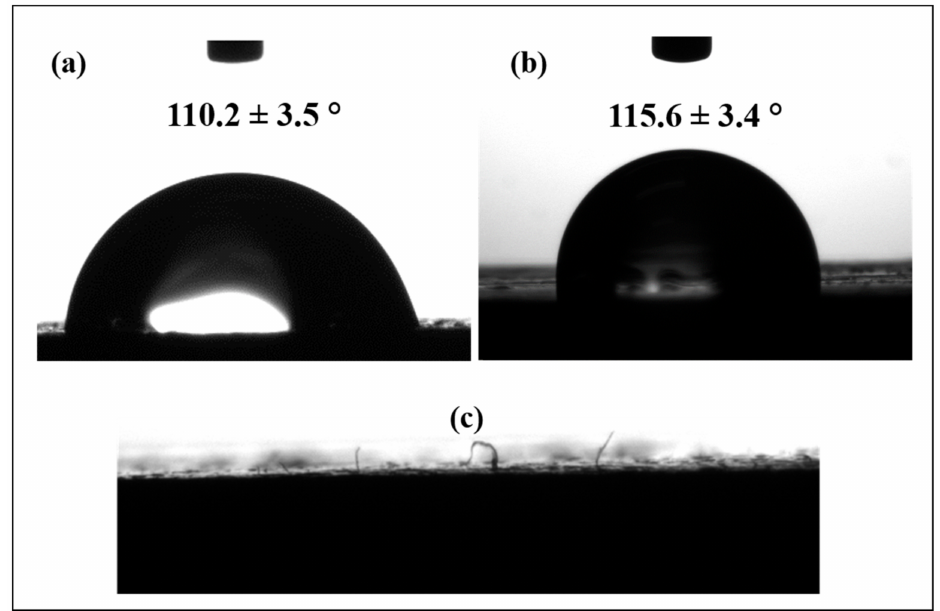
Figure 9. Water contact angle photos of ( a ) PLA10WB and ( b ) TPE10WB and ( c ) of the surface of the PLA10WB sample in which WB fibers are recognizable.